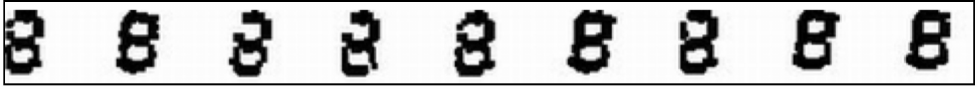
Table 1. Distances between binary templates, expressed in terms of logical operators, where |A| is the number of ones in vector A. A corresponds to the expected template. B is the template extracted from the image capture. In the case of the MONICOD distance the denominators of the expression are fixed and can be pre-calculated which speeds up the calculation of the distance expression.